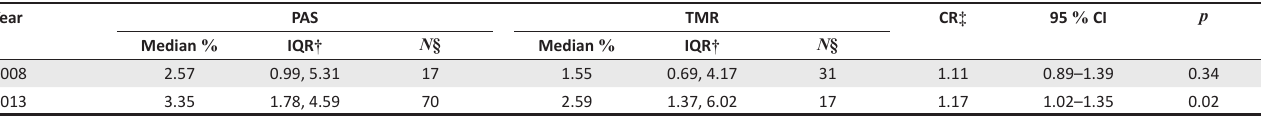
TABLE 4: Comparison of the median within-herd prevalence in Streptococcus uberis- positive herds in different systems within the same year. Year PAS